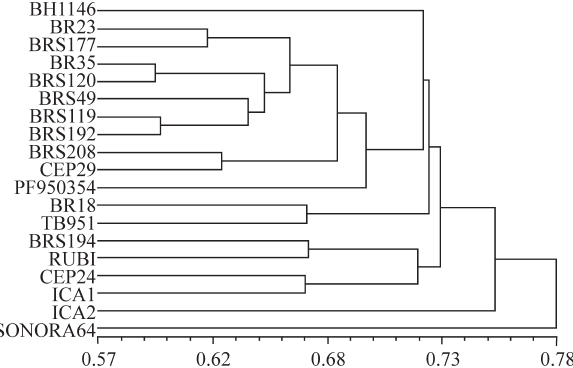
Figure 3 - Combined morphological character and amplified fragment length polymorphism (AFLP) marker unweighted pair group method with arithmetic means (UPGMA) dendrogram resulting from the analysis of 19 wheat genotypes using the complement of the similarity index of Gower (1971) obtained from the combined analysis of phenotypic and AFLP markers as a measure of genetic dissimilarity. The value of the cophenetic correlation coefficient (r) was 0.81.